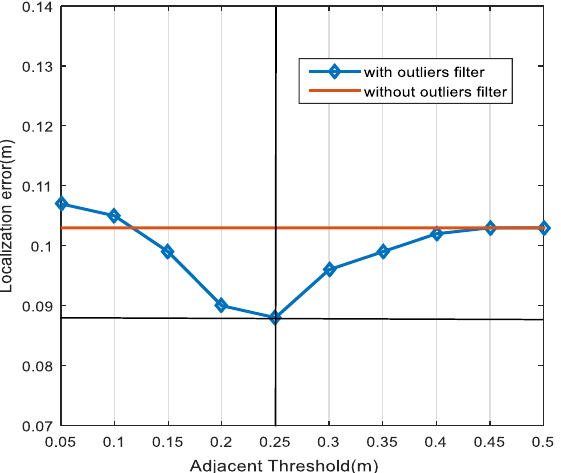
Figure 15. Effect of the adjacent thresholds on the localization accuracy.